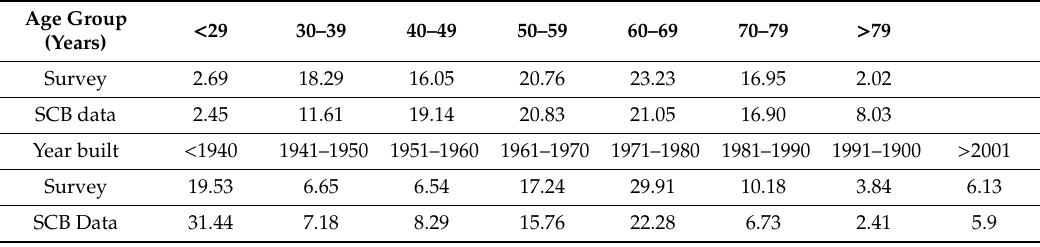
Table 1. Distribution (%) of age of house owners and house construction year in our sample compared to SCB data.